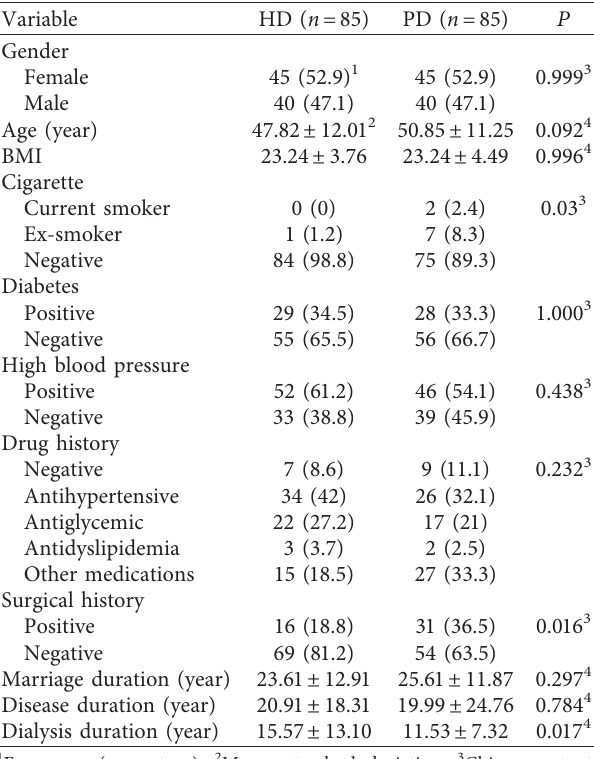
Table 1: Comparing baseline data between HD and PD